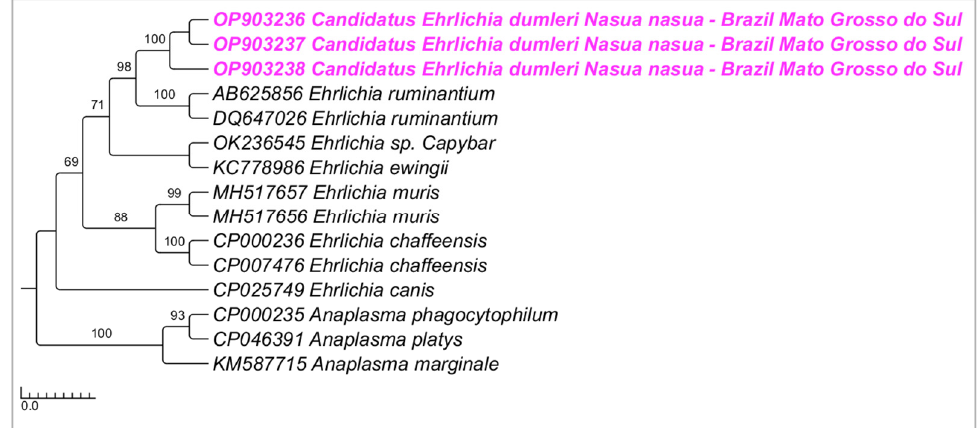
Figure 4. Phylogenetic tree inferred by the Bayesian method and based on the sodB gene from Ehrlichia spp. sequences obtained from blood from ring-tailed coatis ( Nasua nasua ) sampled in Campo Grande city, Mato Grosso do Sul state, Brazil. Sequences detected in the present study are highlighted in bold pink (VBA).